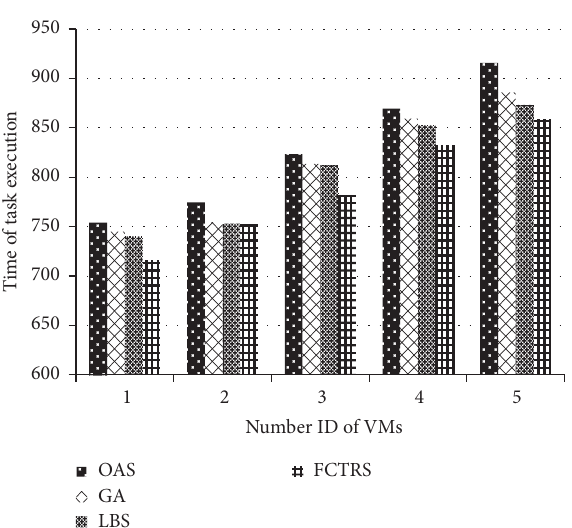
Figure 8: Resource distribution across the virtual machines of different algorithms. Figure 9: Task execution time of each processing unit adopting different virtual resource scheduling